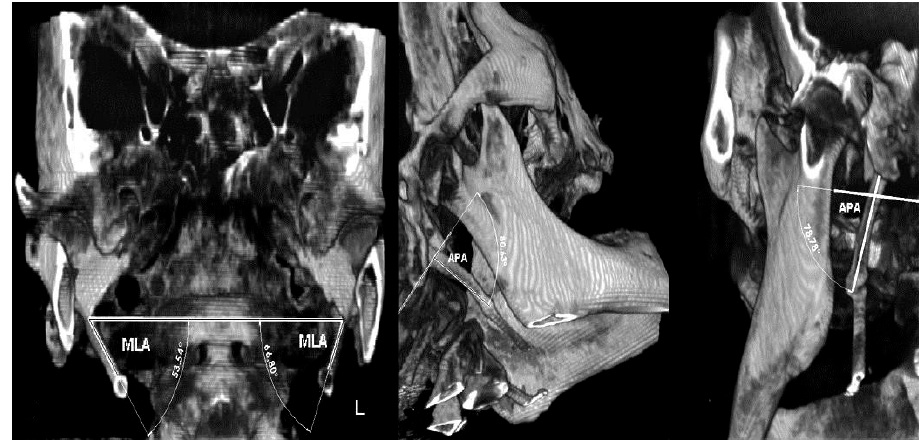
Figure 6. 3D measurement of angles for analyzing a “normal-pathological” SHC: ( left ) measurements of mediolateral angling (MLA) of a calcified/ossified coronal 3D-CBCT image; ( middle ) measurements of right anteroposterior angling (APA) of a calcified/ossified SHC with the longitudinal axis of the SHC and Mc Rae’s line; ( right ) measurements of left anteroposterior angling (APA) of a calcified/ossified SHC with the longitudinal axis of the SHC and Mc Rae’s line. The patient was scheduled for the odontectomy of the impacted non-erupted left maxillary canine, which was surgically extracted. The patient experienced the complete resolution of previous cervicofacial pain episodes one month after odontectomy, with a subsequent cessation of further visits to our institution.